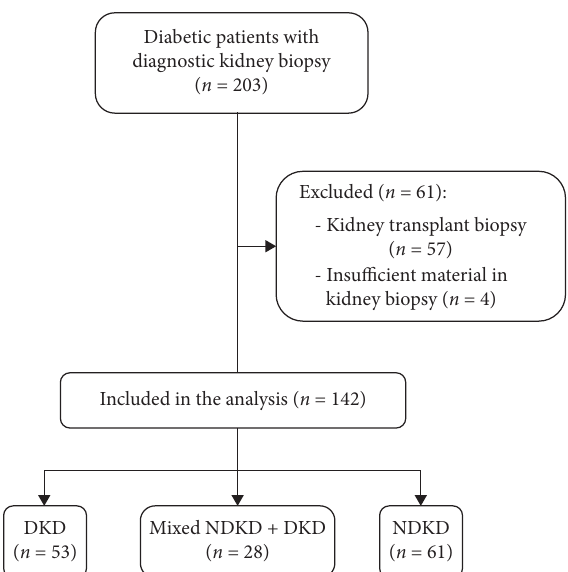
Figure 1: Study design and patients’